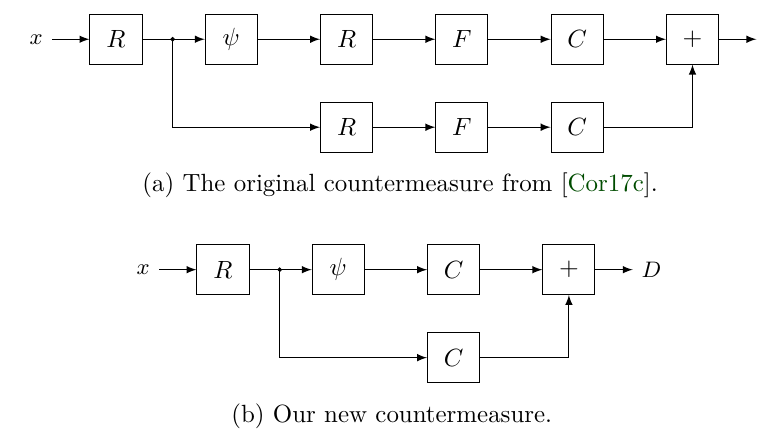
Figure 1: The sequence of operations in the Boolean to arithmetic conversion